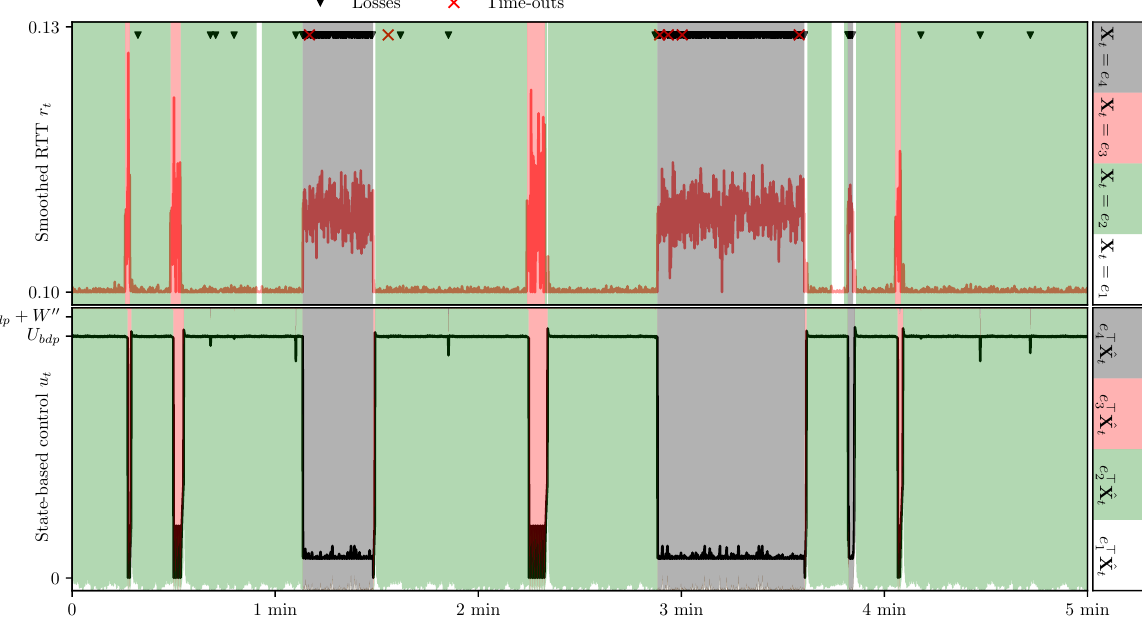
Figure 7. TCP channel simulation example for state-based control